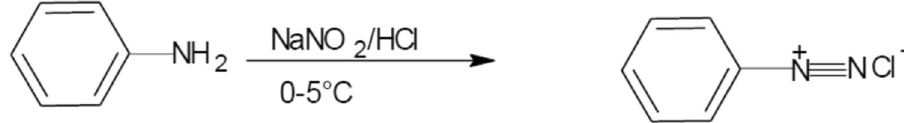
Fig. 2 Diazotization of aniline using HCl and NaNO low